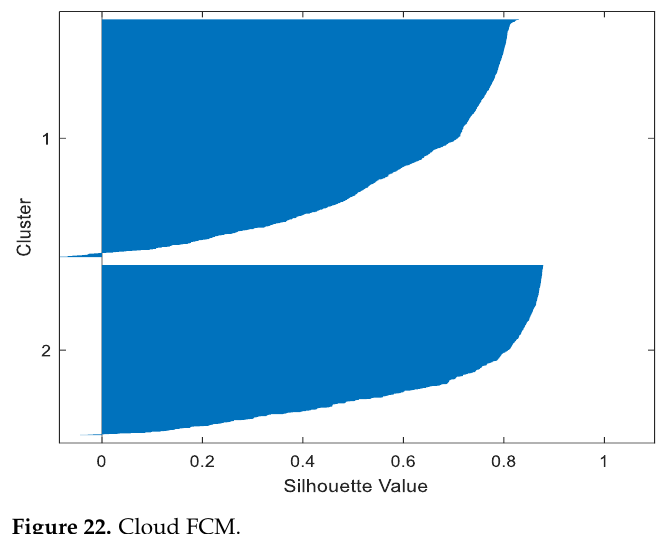
Figure 21. Cloud FP-Conv-CM.